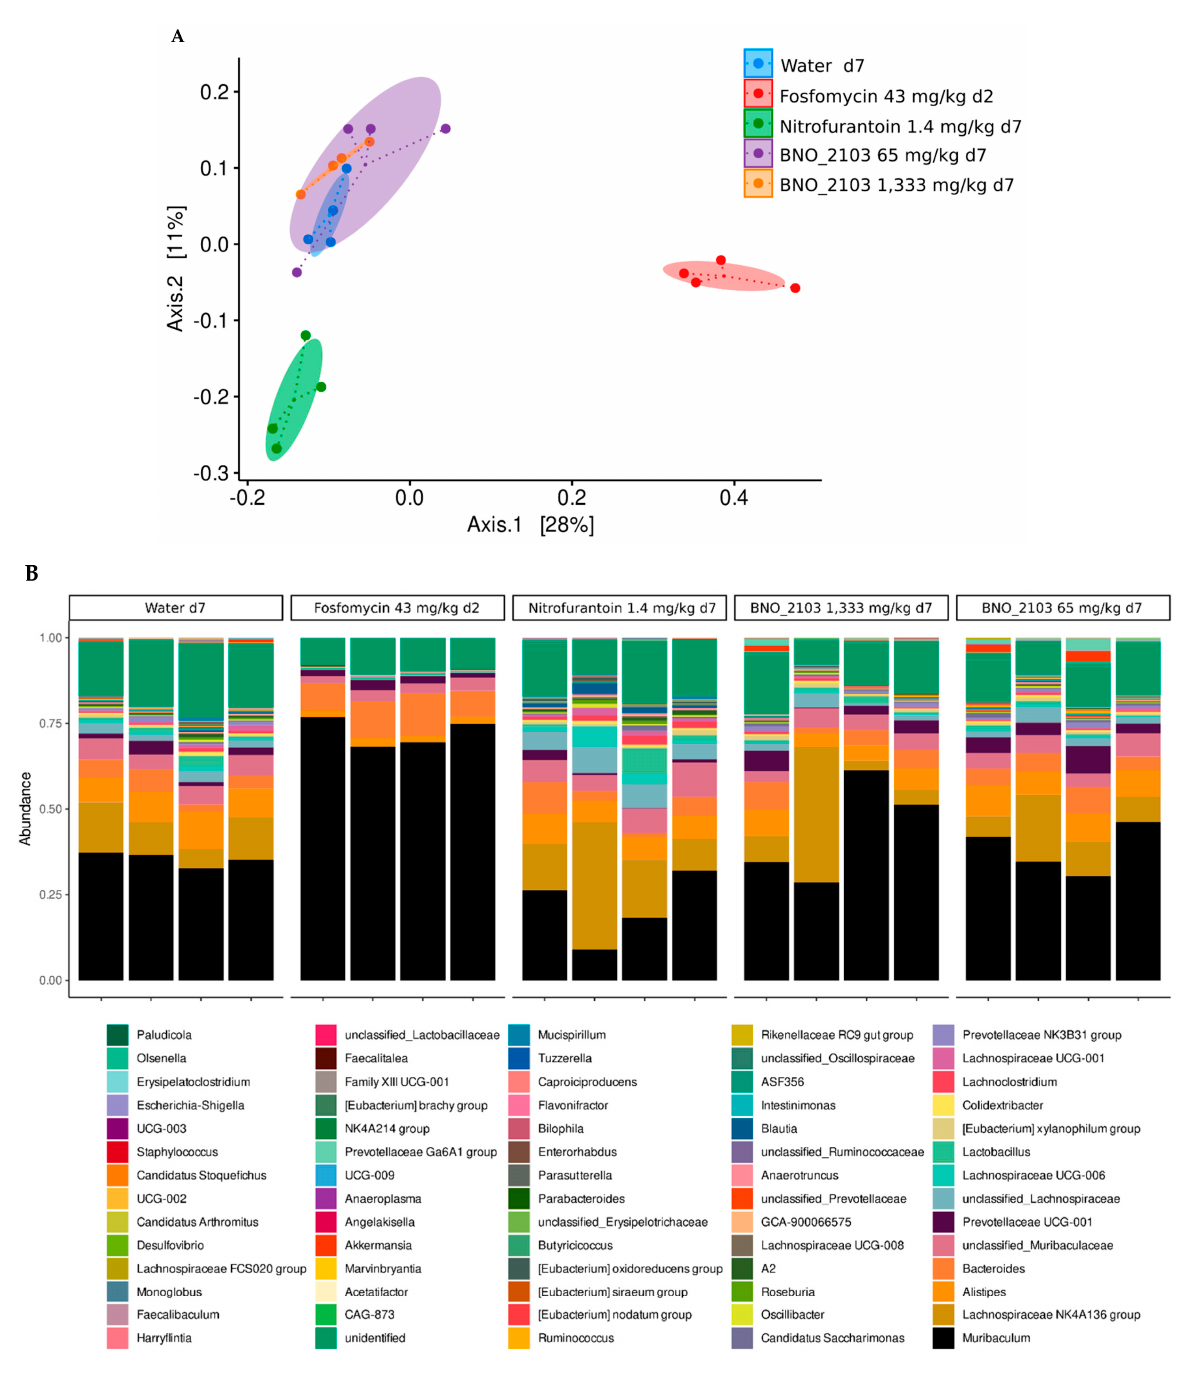
Figure 2. Changes in microbiome after treatment of mice with fosfomycin (day 2 after a single dose), nitrofurantoin (day 7), and BNO 2103 (day 7), compared to a control group (water, day 7). ( A ) Similarity between individual bacterial compositions were studied using principal coordinates analysis (PCoA) of 16S rRNA gene sequencing data. Individual samples (colored dots) clustered well, according to the treatment groups. Ellipses represent the 95% confidence intervals, based on a multivariate t-distribution for each group. The center of each group is marked by small dots. Differential clustering of samples after treatment with fosfomycin or nitrofurantoin indicates compositional shifts after antibiotic treatment of mice, while mice treated with BNO 2103 or controls are clustering together, denoting similar bacterial compositions. Coordinates represent 28 and 11 percent of total variance of the dataset. ( B ) Taxonomy bar plot illustrating relative abundance of detected bacterial genera in samples and treatment